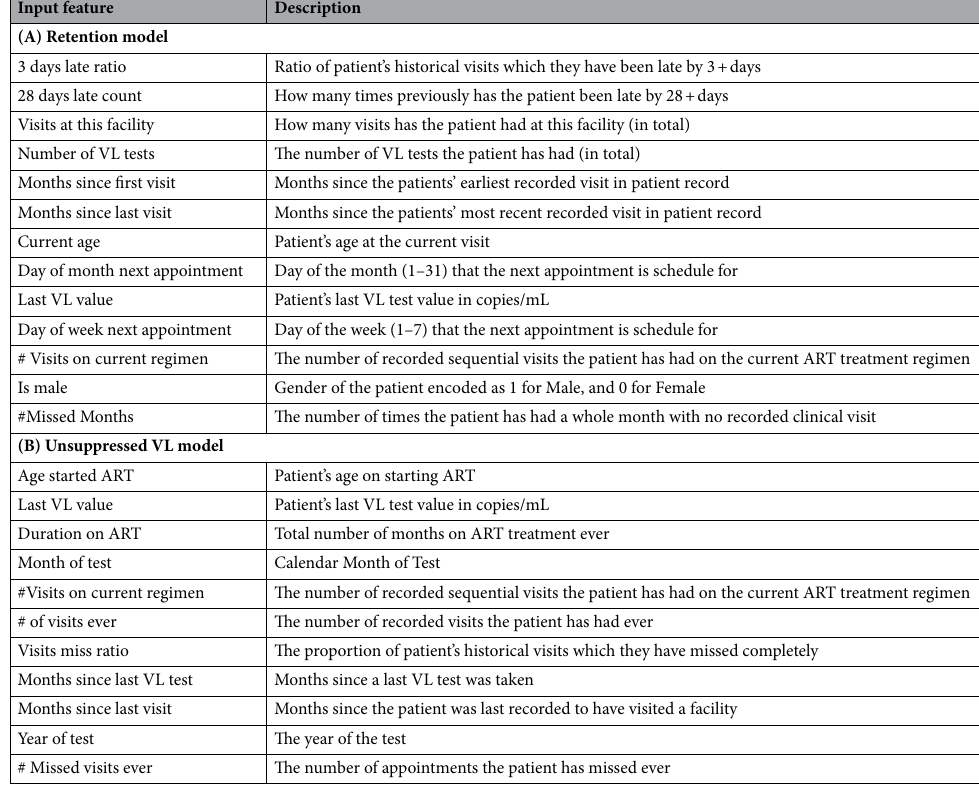
Table 1. Input features for the (A) retention model and (B) unsuppressed VL